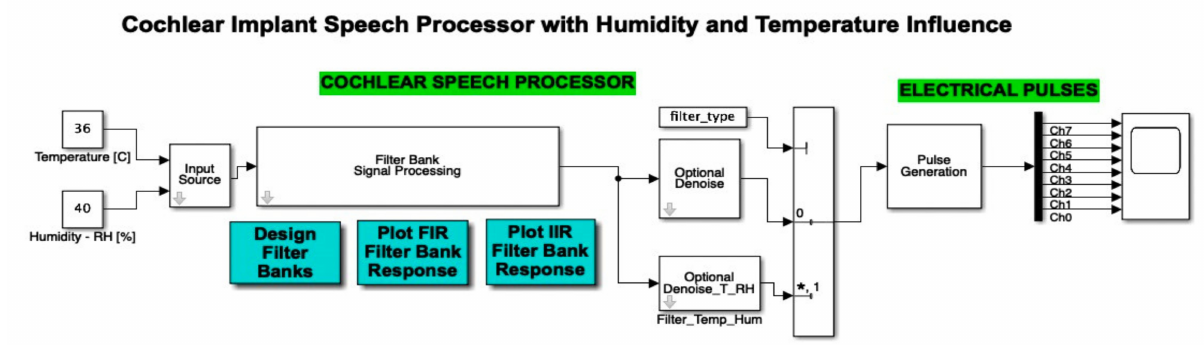
Figure 18. Simulink diagram of the denoise stage for the temperature and humidity influence. (*: value at the address of variable).